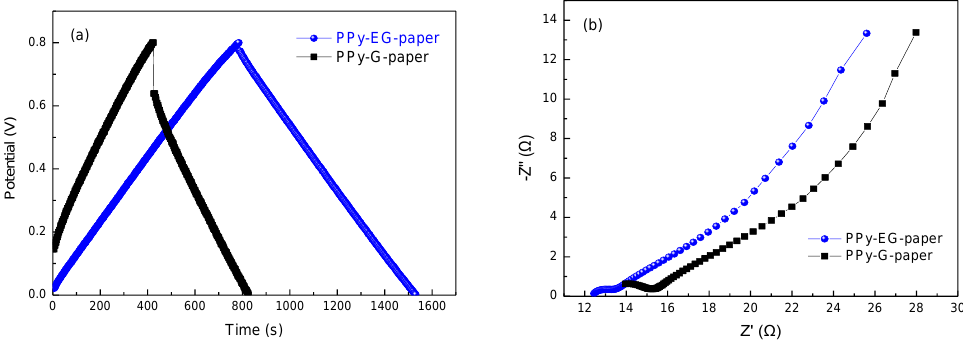
Figure 7. ( a ) GCD curves of PPy-G-paper and PPy-EG-paper at a current density of 0.8 mA ∙ cm − 2 ; and ( b ) Nyquist plots of PPy-G-paper and PPy-EG-paper.